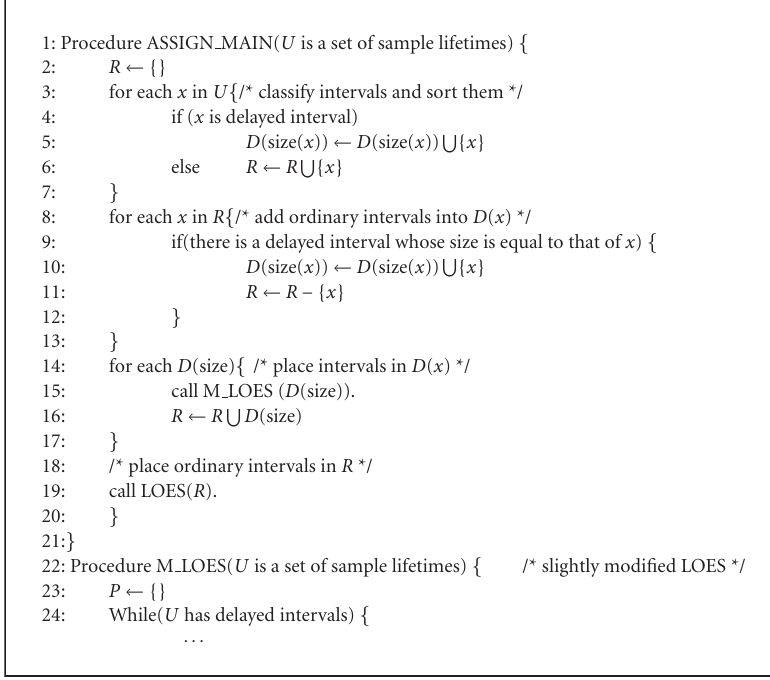
Figure 17: Pseudocode of the proposed algorithm for a graph with